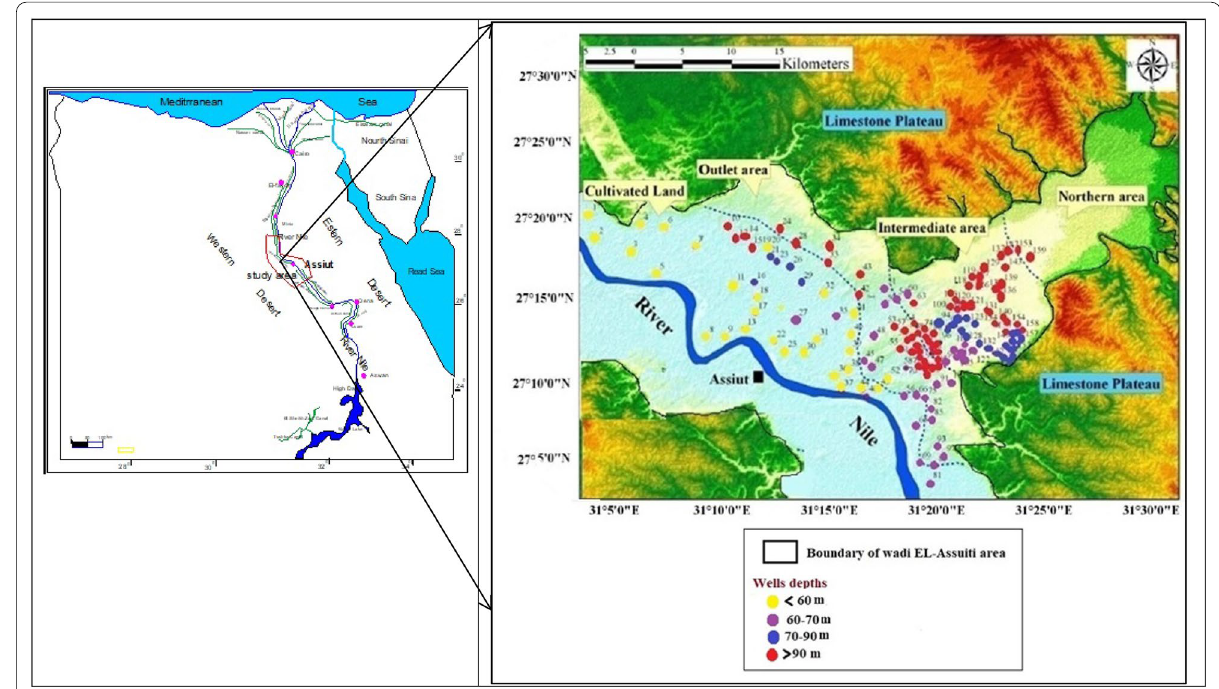
Fig. 1 Location map with monitoring wells in the study